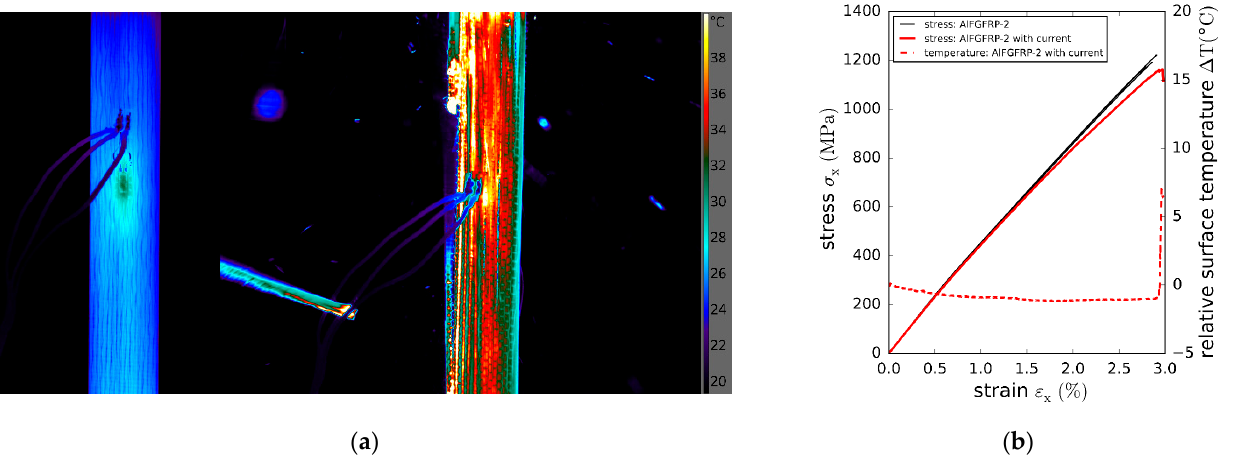
Figure 24. Combined tensile test with electrical load: ( a ) thermographic images of a mechanically unloaded specimen carrying a current of 5 A (left) and at the moment of final rupture (right); ( b ) stress–strain results and surface relative temperature of the current- and non-current carrying specimen.